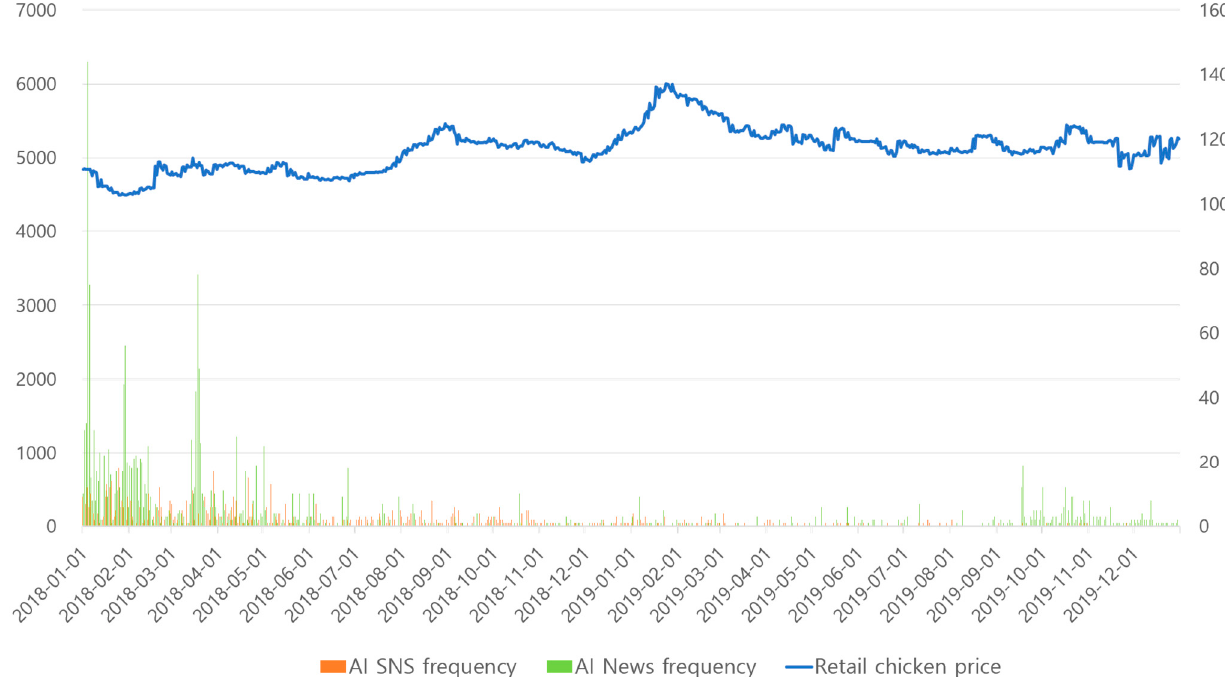
Figure 1. Trends in retail pork prices, African Swine Fever (ASF)-related news and SNS frequencies in 2019. The x axis indicates time and the y axis indicates retail pork price and frequency.